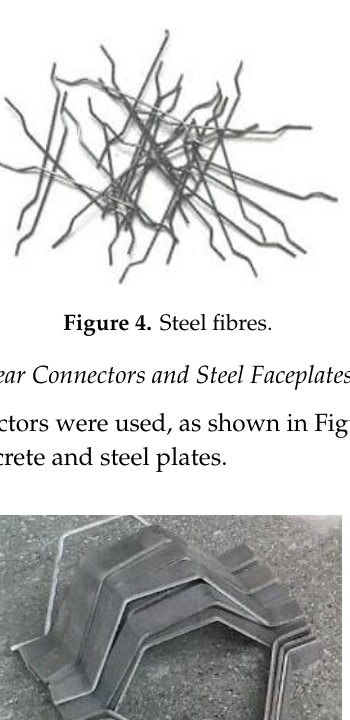
Table 5. Mechanical properties of steel faceplates and CSCs. Thickness (mm) 207 Figure 6. Geometric properties of CSC shear connectors.